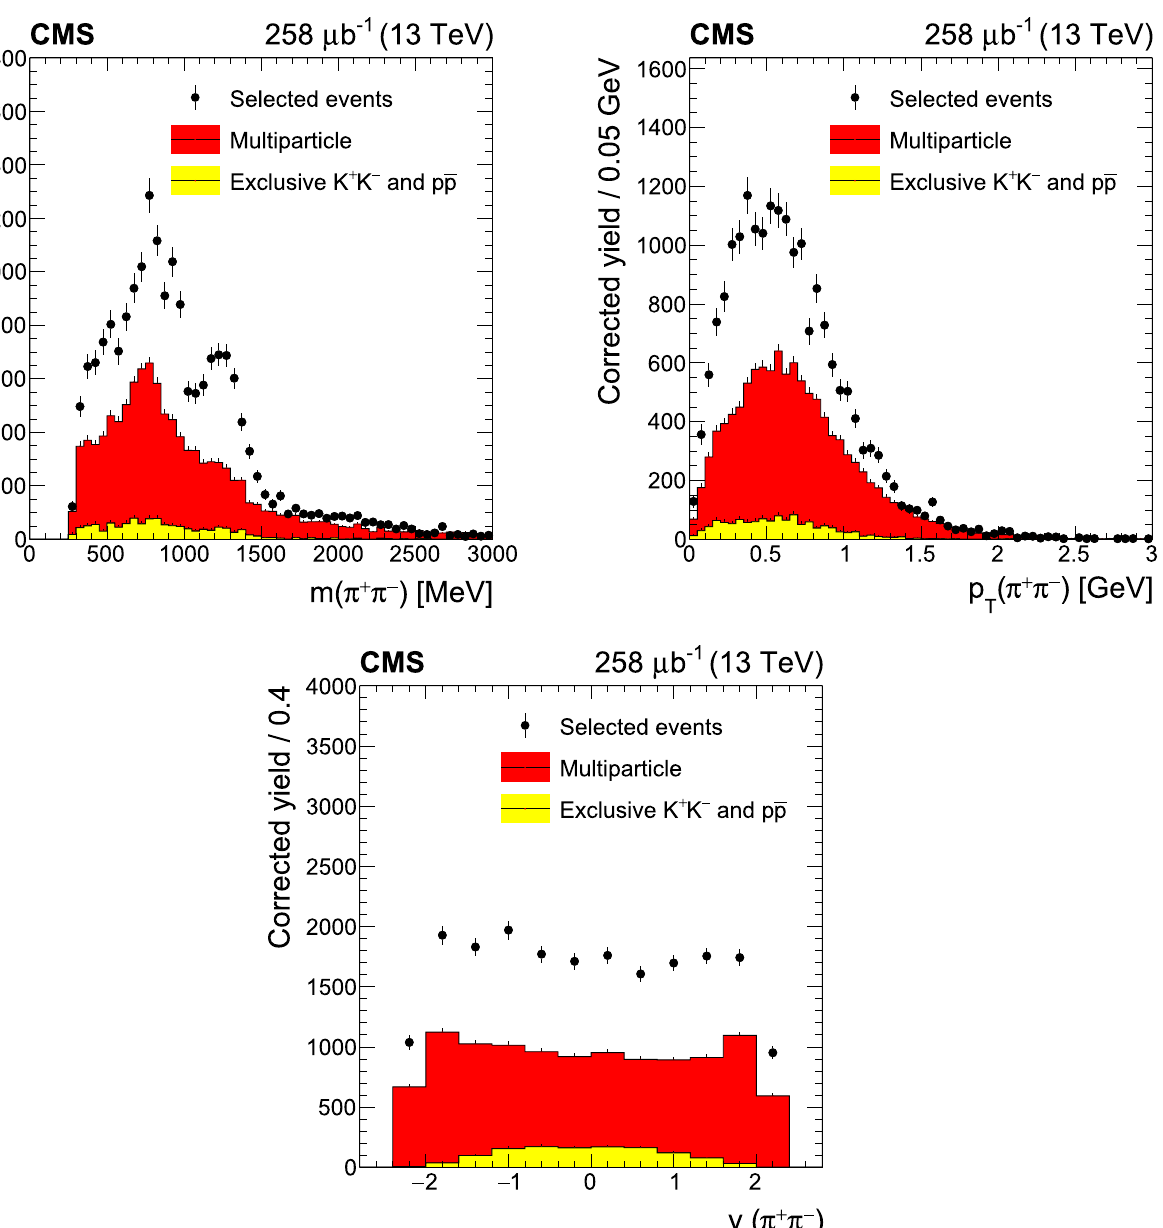
Fig. 4 Background distributions as functions of kinematic variables estimated by data-driven methods. The proton dissociation background is not shown here, since it is included via scaling of the final cross sec-